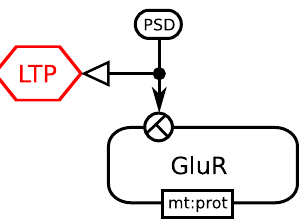
Figure 2.19: Example of a phenotype “Long Term Potentiation (LTP)” enhanced when the entity “GluR” is present in the post-synaptic density.